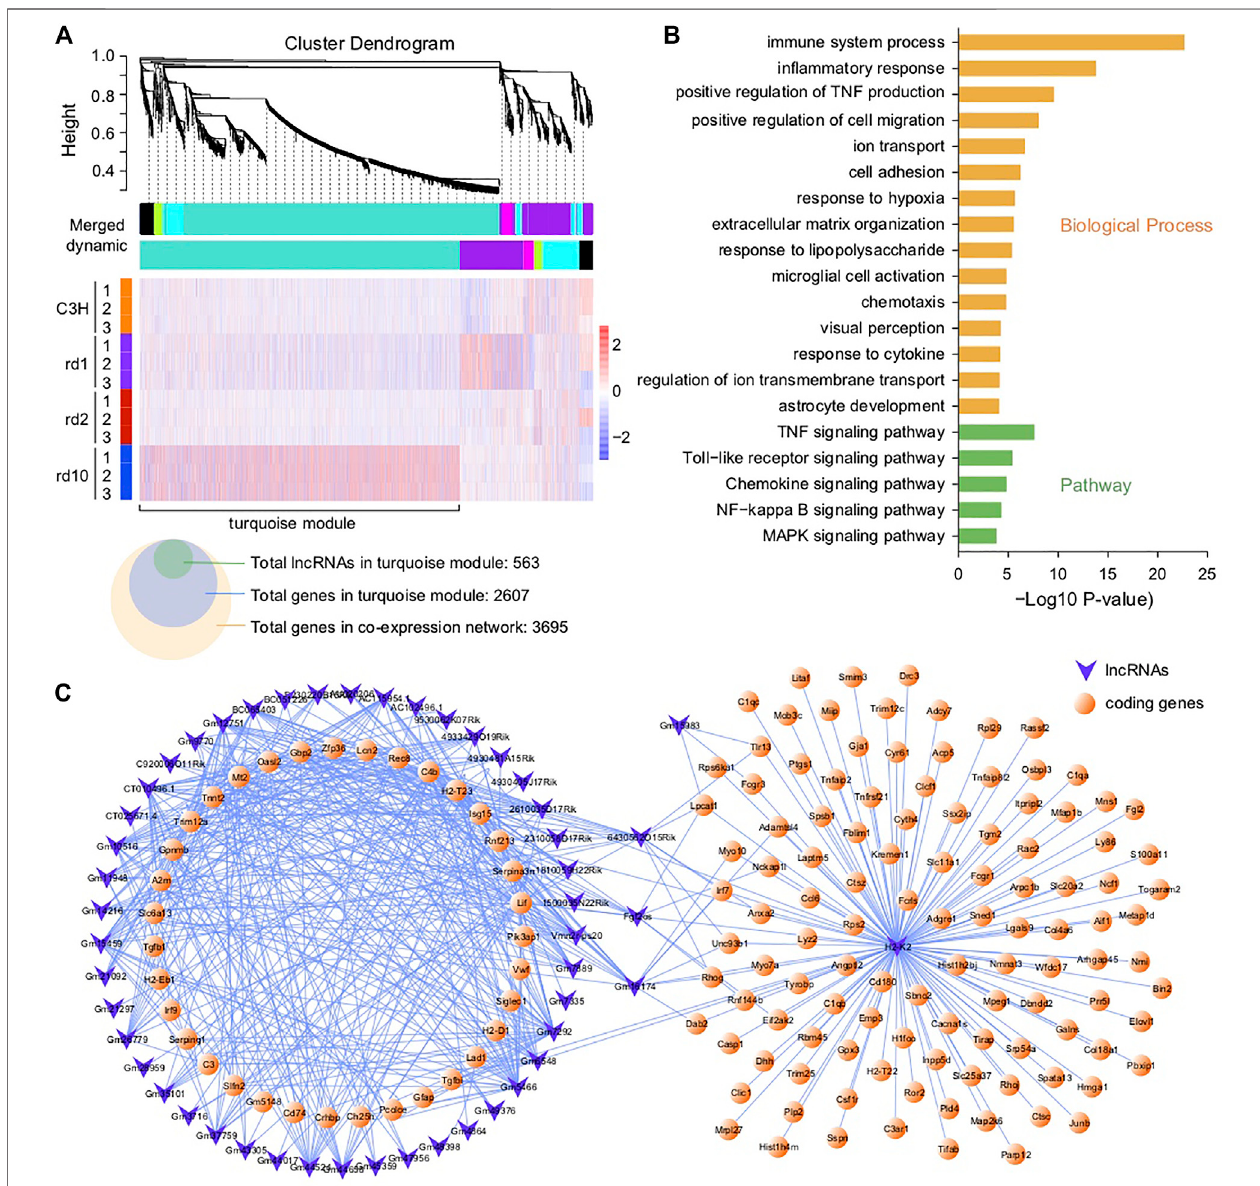
FIGURE 5 | Co-expression network analysis of DE lncRNAs and coding genes. (A) Co-expression modules of DEGs and their expression pro fi le in all samples; A totalof563DE-lncRNAsand2,607geneswerefoundinturquoisemodule,and3,695genesintheco-expressionnetwork. (B) FunctionalenrichmentanalysisofDEGsin the turquoise module; The genes in the networks were signi fi cantly enriched in immune system process, in fl ammatory response, positive regulation of TNF production, TNF signaling pathway, Toll-like receptor signaling pathway, chemokine signaling pathway, and MAPK signaling pathway. (C) Network connections of lncRNAs with coding genes in the turquoise module — only topological overlap matrices with > 0.69 similarity are